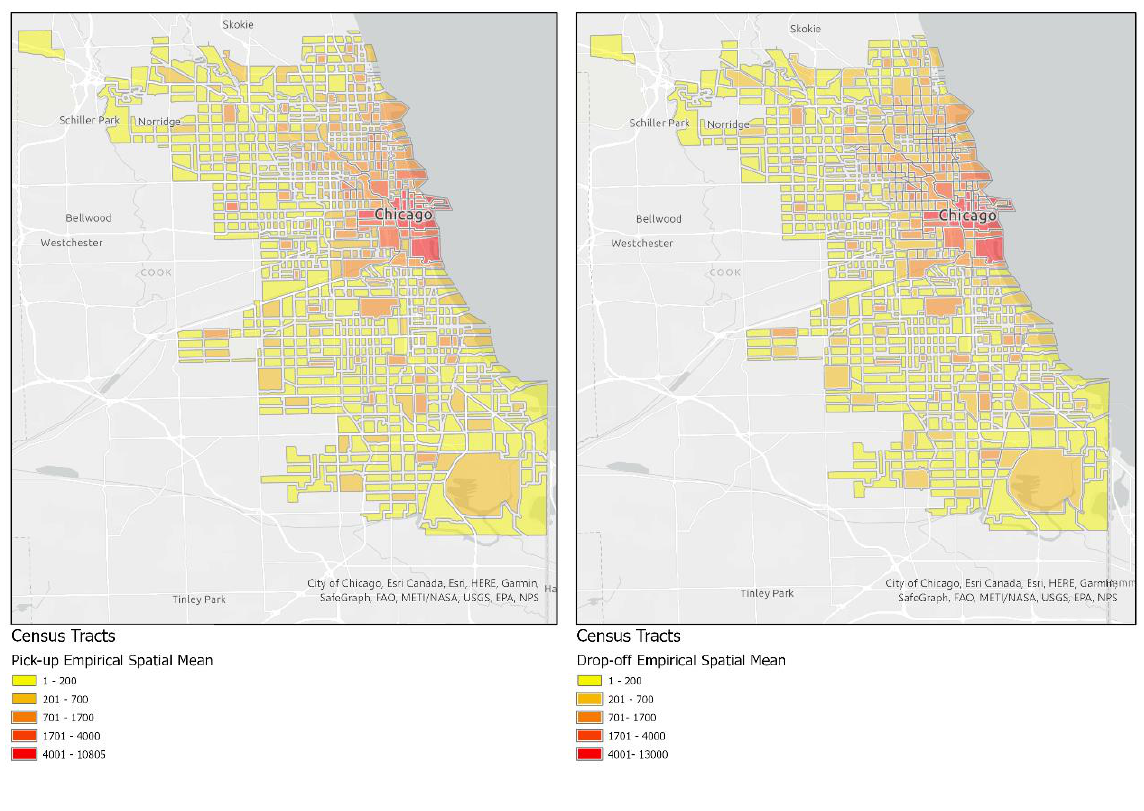
Figure 3: Empirical Spatial Means for Daily Pick-ups and Drop-offs in the Year